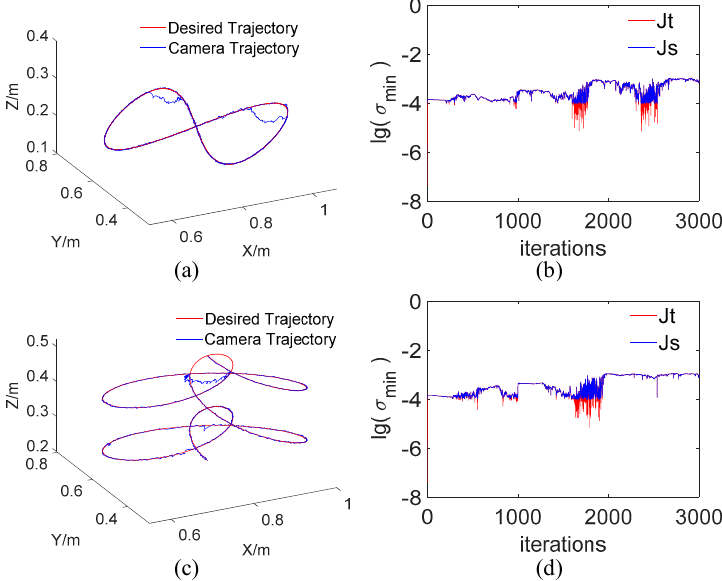
Figure 11. ( a ) Inaccurate trajectory caused by an unstable conditional number in a double leaf rose path. ( b ) Logarithm of the minimum singular value of the total Jacobian in a double leaf rose path. ( c ) Inaccurate trajectory caused by an unstable conditional number in a triple leaf rose path. ( d ) Logarithm of the minimum singular value of the total Jacobian in a triple leaf rose